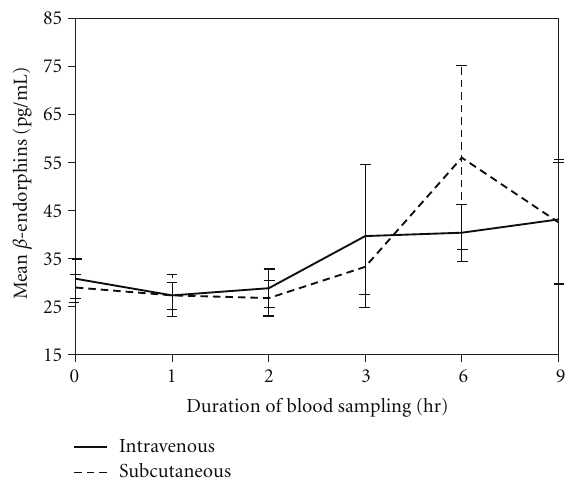
Figure 5: Mean serum β -endorphin concentrations for the IV and SC groups at di ff erent sampling times after tramadol administration ( P = 0 .